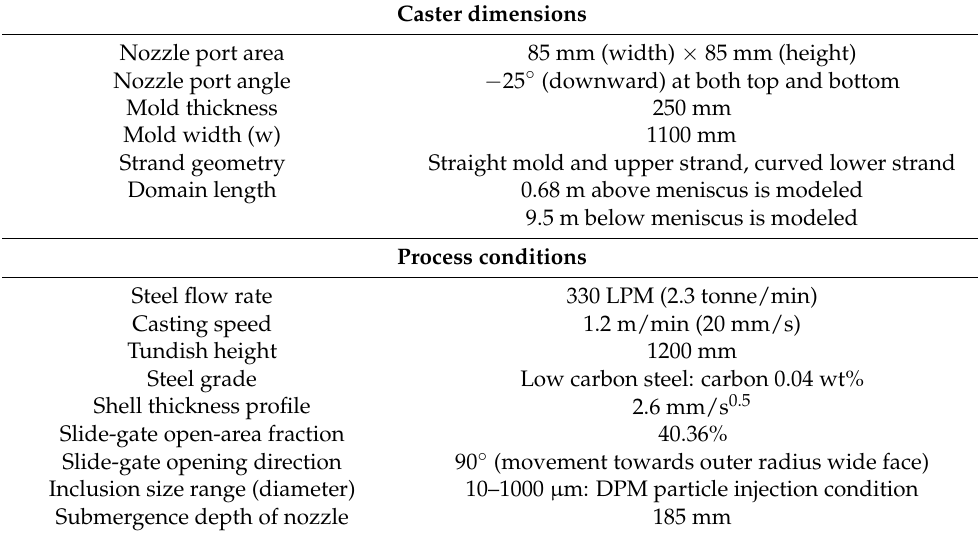
Table 1. Caster dimensions and process